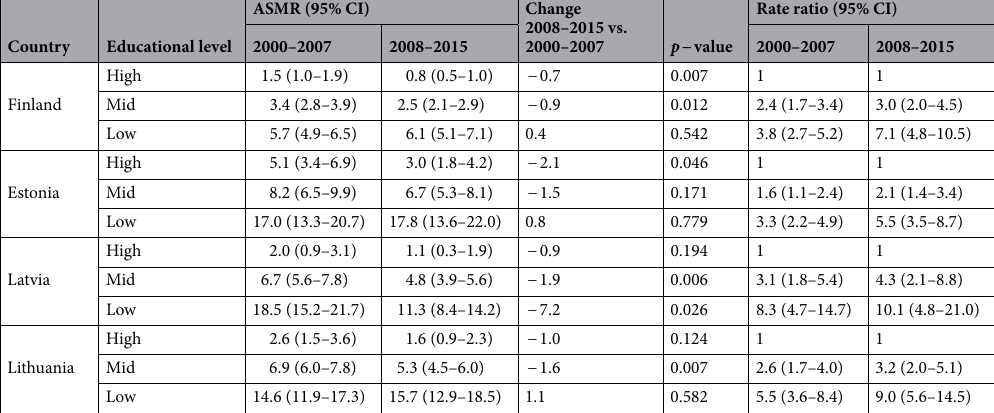
Table 2. Age-standardised mortality rates per 100,000 person years and mortality rate ratios by educational level for epilepsy in 2000–2015 among men in the 30–74 age group. ASMR age-standardised mortality rate per 100,000 person years, CI confidence interval.